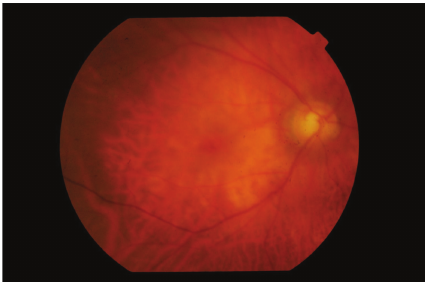
Figure 1: Pale optic disc and macular edema with cherry red spot.